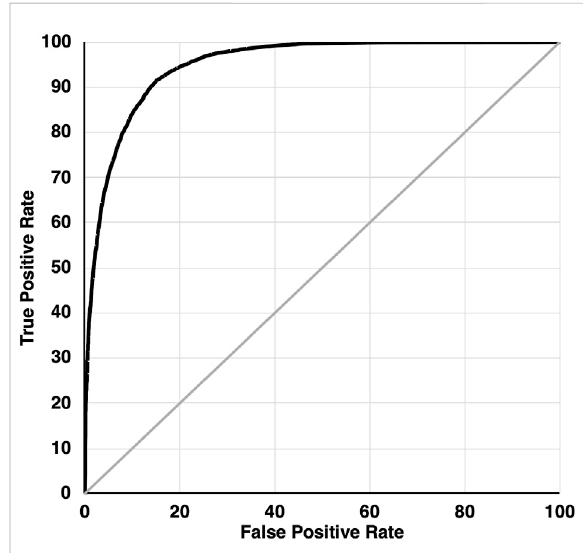
FIGURE 4 Receiver Operator Characteristic (ROC) curve illustrating the goodness-of- fi t of the mountain goat winter habitat suitability model, plotting the rate of true positives against false positives for the target variable classifying observations versus random points under different discrimination